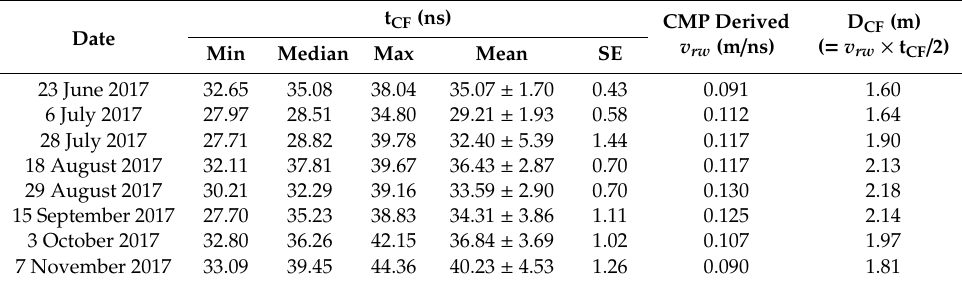
Figure6. Semblanceanalysisforvelocityestimationofcommonmidpoint(CMP)dataon( a )23 June 2017 ( v rw = 0.091 m / ns) and ( b ) 31 October 2018 ( v rw = 0.074 m / ns). Table 2. Ground penetrating radar (GPR) estimated depth to the top of the capillary fringe (D CF ) which is derived from the mean two-way travel time (TWTT) to the capillary fringe reflection (t CF ) and common mid point (CMP) derived radar wave velocity ( v rw ) using Equation (2) for all GPR surveys. Standard error (SE) of mean, and minimum (Min), median, and maximum (Max) of t CF time picks are also